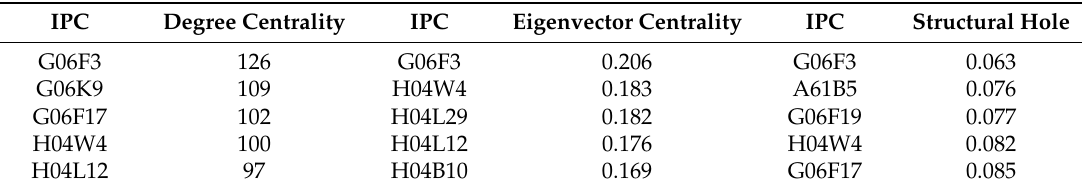
Figure 2. IPC network for machine learning in optical communications. Note: node size represents the number of connections with a node, and the arc thickness represents the strength of a connection. This diagram only displays nodes with 60 or more connections. Table 5. Top 5 IPC codes for machine learning in optical communications.